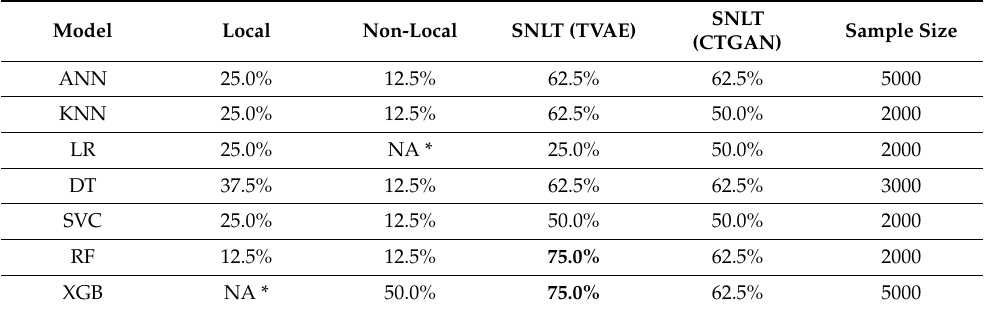
Table 5. Train SD, test OH with 8 samples: best accuracies (bold) from OH local training, non-local training (SD), and SNLT with CTGAN and TVAE (SD), each for three class labels (high, medium, and low yield), plus size of synthesized dataset.